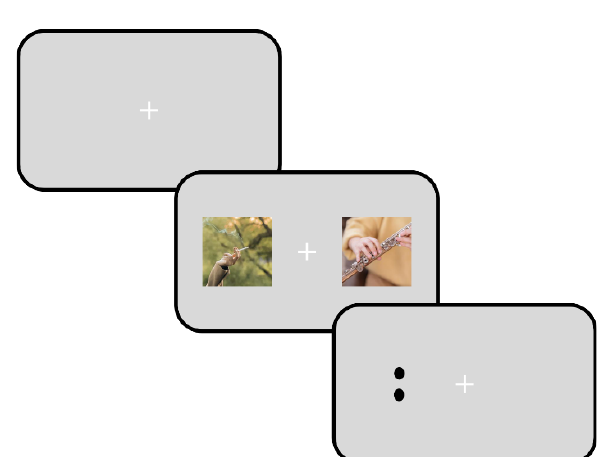
Figure 1. Schematic representation of the general paradigm used to test whether smoking-related content cues overt attention. Observers fixate centrally until two images, left and right of fixation, are presented, usually for one or two seconds. One of the images is related to smoking (unpredictably left or right, here left) whereas the other image is unrelated. The observer is free to move the eyes between the two images during their presentation. Commonly, a visual probe stimulus is also presented after the images, randomly left or right of fixation, in this case the two black dots. The observer is then asked for a speeded discrimination of the probe stimulus (e.g. indicating the number of dots) or to look towards it. Attentional cueing by smoking- related content is evidenced by oculomotor measures (e.g. longer dwell time on the smoking-related image) and by manual response times to the probe (i.e. relatively faster responses when the probe appears on the same side as the smoking-related